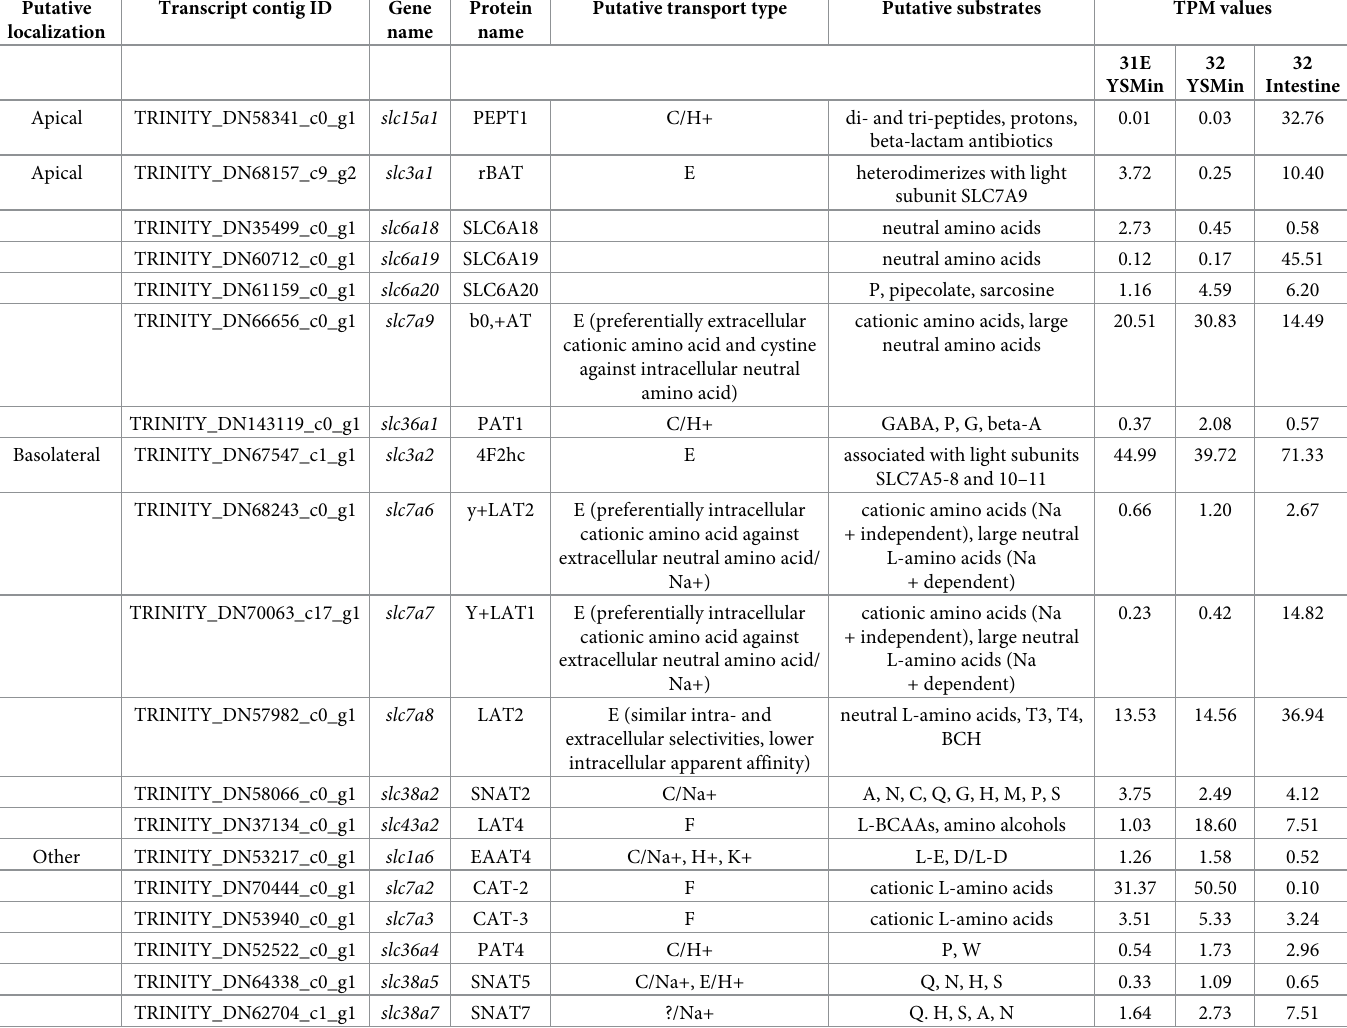
Table 1. Amino acid transporter genes expressed in yolk sac membrane and intestine identified in transcriptome